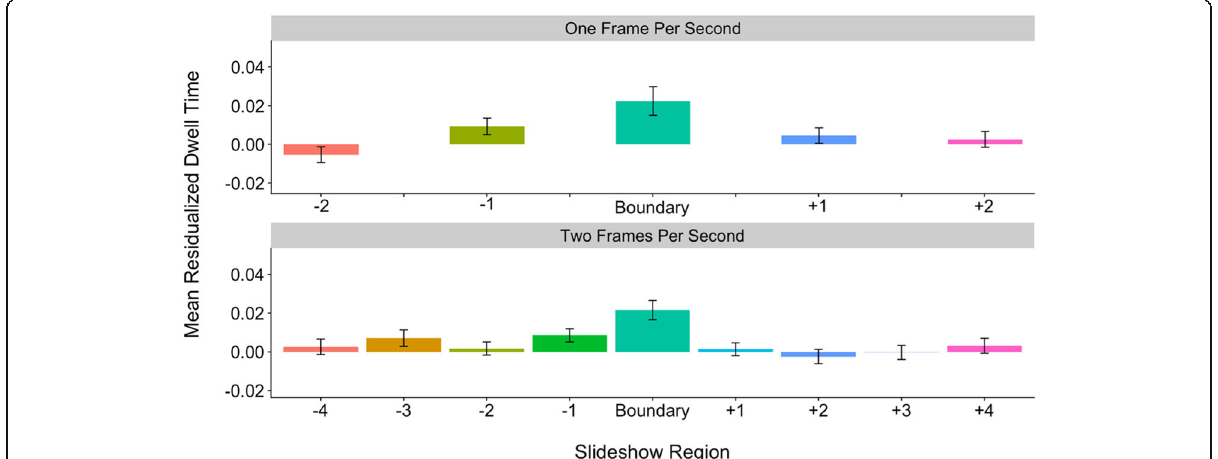
Fig. 5 Average residualized dwell times (± standard error) by region, resolution, and slide type for fine-level boundaries. Slides occurring one and two pre-boundary and one and two post-boundary were included. Bars in the same color represent the same slide content across 1-fps and 2 fps-slideshows (i.e., these are the matched slides). fps frames per